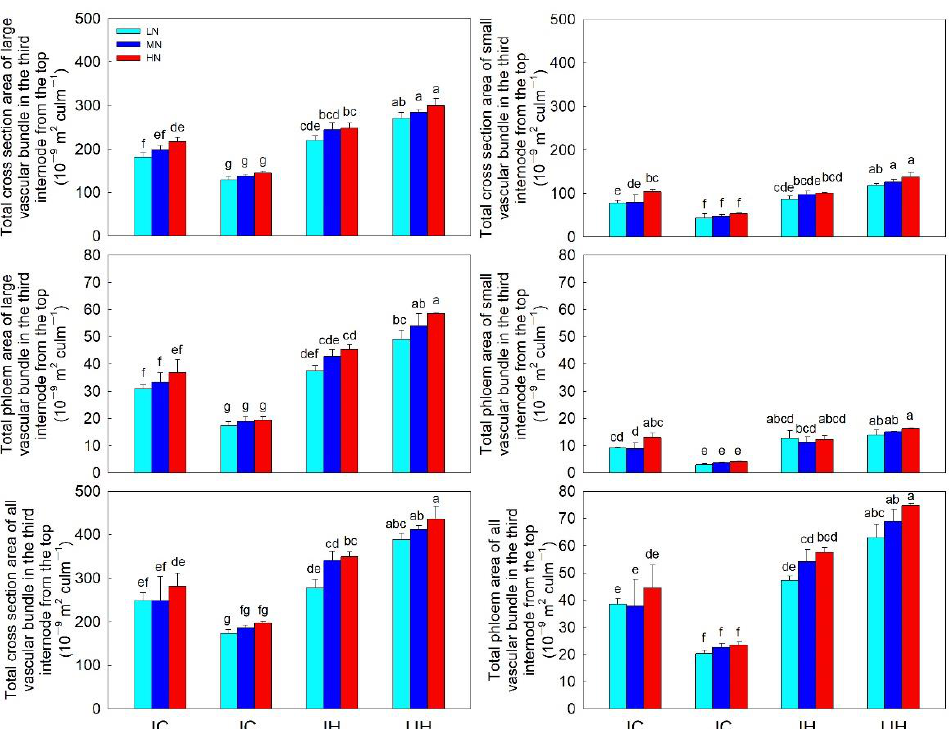
Figure 7. Total cross sectional areas, total phloem areas of large and small vascular bundles, total cross sectional areas and total phloem areas of all vascular bundle in the third internode from the top of different rice varieties under different nitrogen application levels. Different letters on top of histograms indicate significant differences at p < 0.05 among different rice varieties under different nitrogen application levels. IC, indica conventional rice; JC, japonica conventional rice; IH, indica hybrid rice; IJH, indica-japonica hybrid rice; LN, low nitrogen; MN, medium nitrogen; HN, high nitrogen.